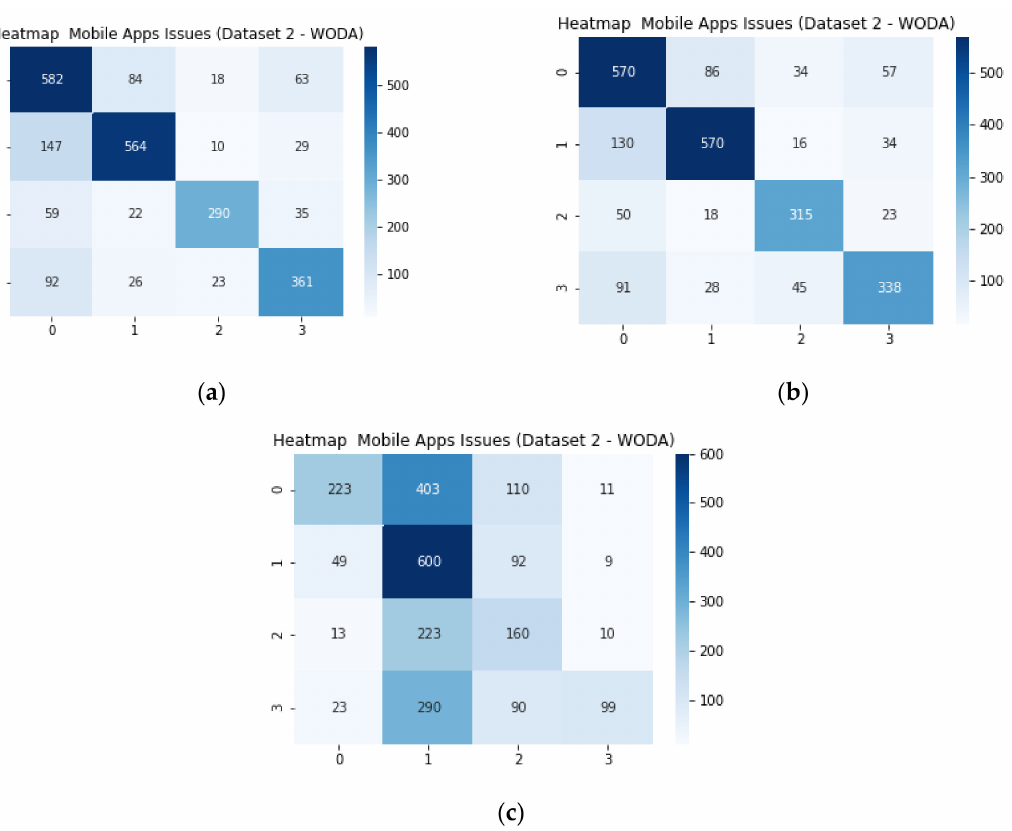
Figure 8. Confusion matrix for ML classifiers suing dataset 2 without data augmentation: ( a ) SVC, ( b ) SGD, ( c ) KNN.